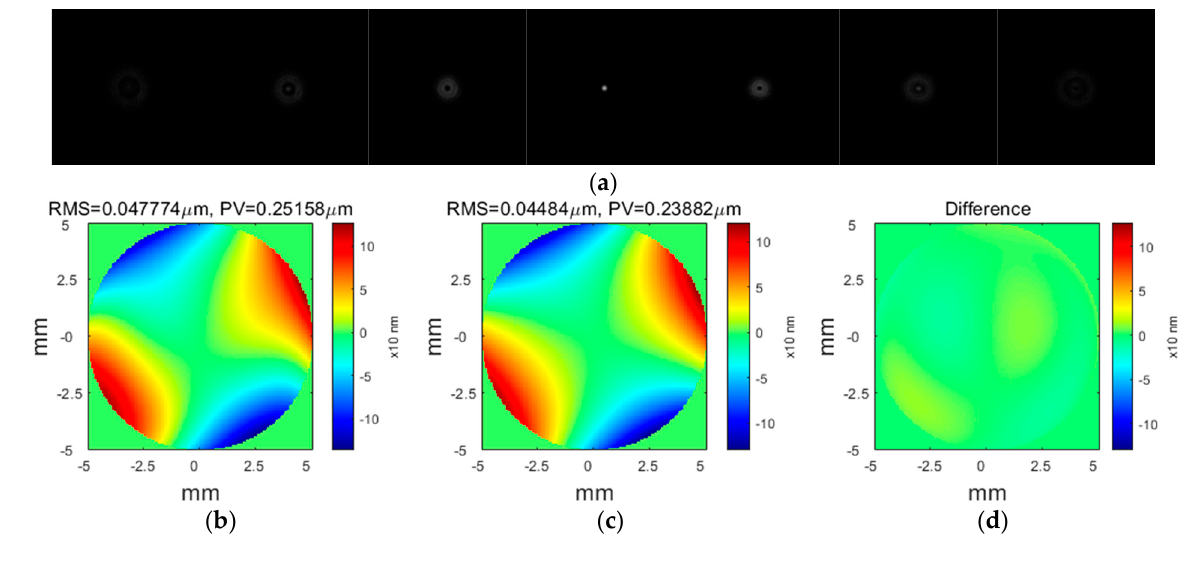
Figure 3. ( a ) Seven 128 pixels * 128 pixels defocused images, from left to right, the defocus is, respectively, − 2.2 mm, − 1.7 mm, − 1.2 mm, 0 mm, 1.2 mm, 1.7 mm, and 2.2 mm; ( b ) the solved result of the estimated surface shape with two images in ( a ) (the defocus amounts are − 1.7 mm and 1.7 mm, respectively) is RMS = 0.047774 μ m and PV = 0.25158 μ m; ( c ) the solved result of the estimated surface shape with all seven images in ( a ) is RMS = 0.04484 μ m and PV = 0.23882 μ m; and ( d ) the difference between the measurement results with two images and with all seven images.